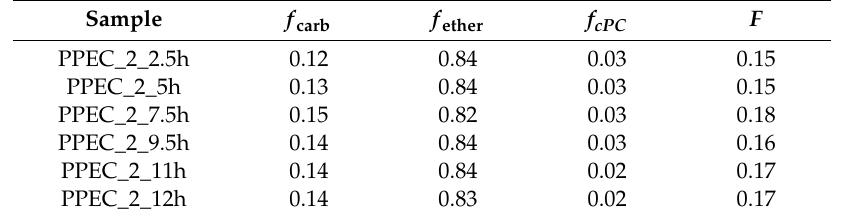
Table 6. Calculated F and cPC content in PPEC_2 synthesized at 120 ◦ C and 10 bar CO 2